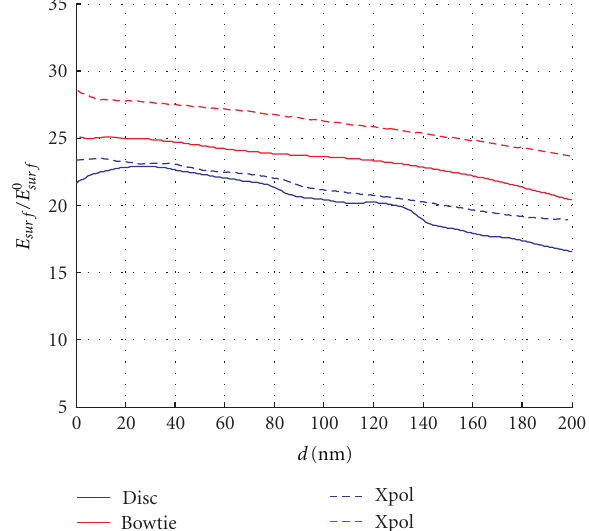
Figure 7: Enhancement ratio for 3-element arrays when the dipolar source is oriented along the alignment axis of the dimers (solid line) and perpendicularly to the alignment axis (dashed line), which is labelled as xpol. The disc dimer case (blue line) and the bowtie case (red line) are plotted as a function of the interelement distance d , for a radius r = 40nm and gap =